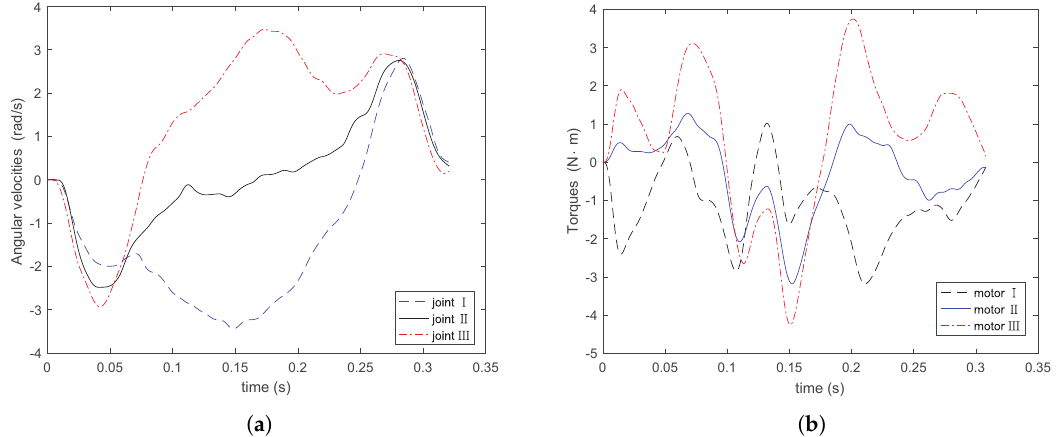
Figure 7. Experimental results of angular velocity and torque by proposed method. ( a ) Angular velocity; ( b ) torque.